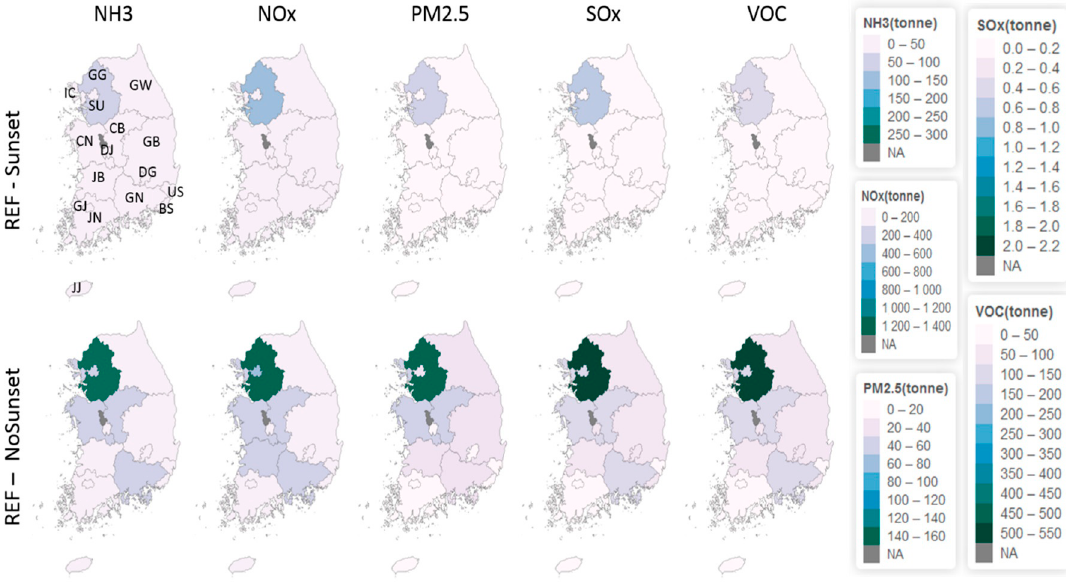
Figure 8. Emission reductions compared to REF in 2040.